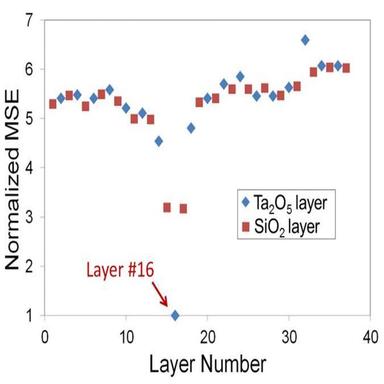
Systematic testing of each individual layer from the "blind" test sample shows significant reduction in the MSE for layer #16. This layer was confirmed to be the altered layer – with double the design thickness, after the SE testing was completed.